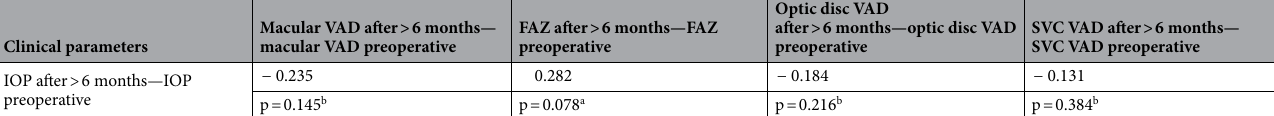
Table 5. Correlation analysis. VAD vessel area density, FAZ foveal avascular zone, SVC superficial vessel complex. a Spearman. b